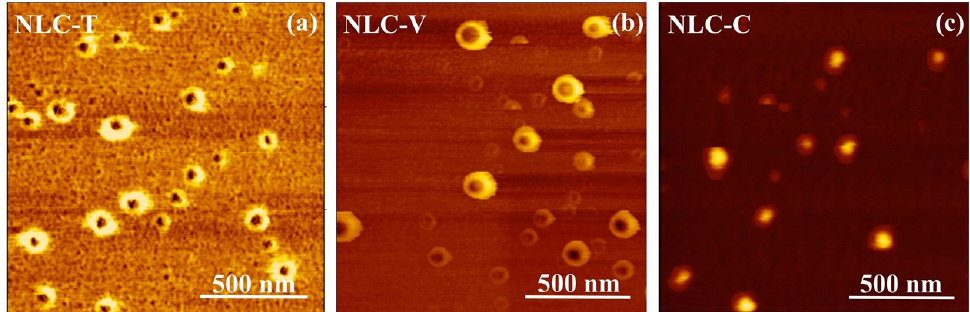
Figure 4. The tapping mode AFM phase images of NLC-T ( a ), NLC-V ( b ), and NLC-C ( c ). The bars are 500 nm.